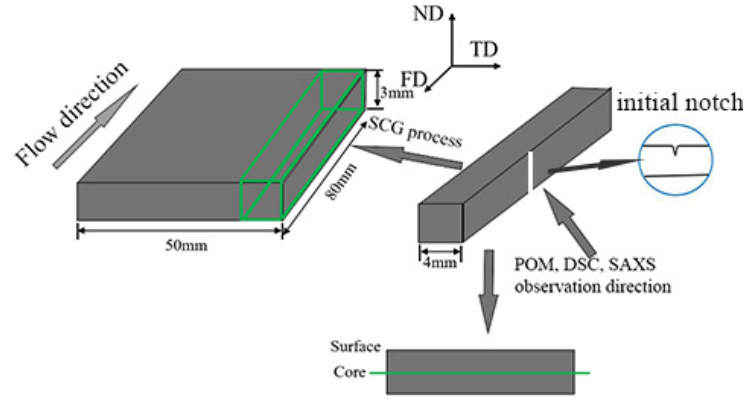
Figure 1. Schematic diagram of sample prepared for characterizations. FD, flow direction; TD, transverse direction; ND, normal direction. Table 1. Molding parameters of vibration injection molding process.